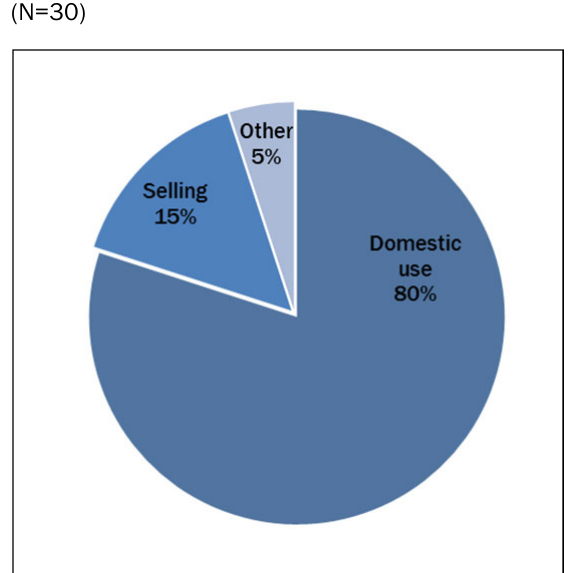
Figure 6. Uses of Urban Agriculture